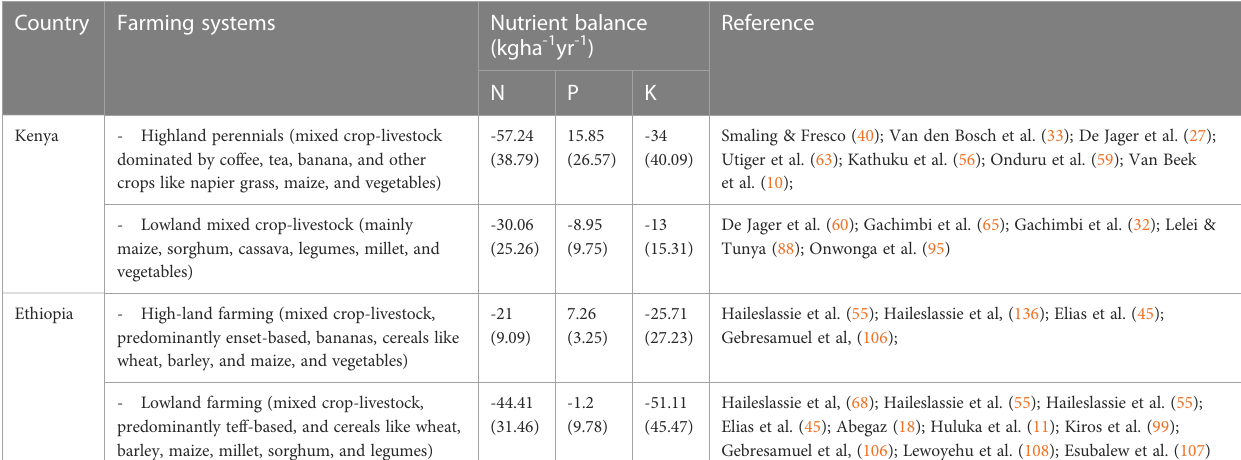
TABLE 2 Average full nutrient balances in the different farming systems.